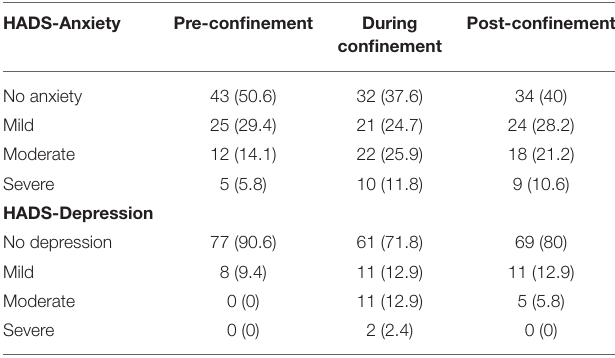
TABLE 4 | The anxiety and depression categorisation levels based on the severity of the reported symptoms.